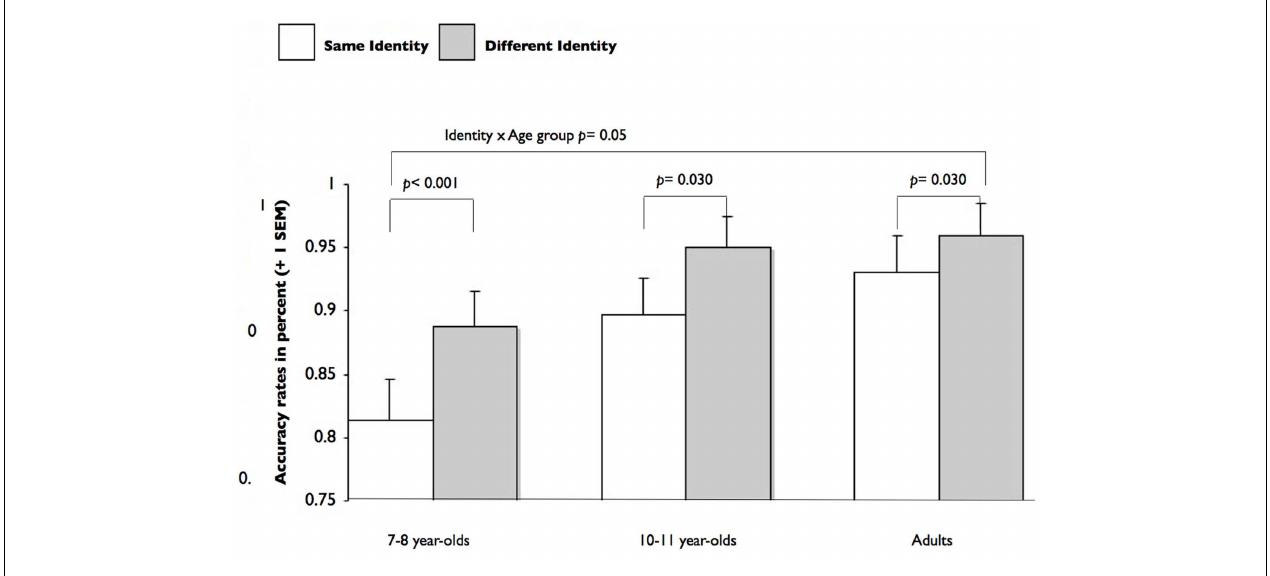
FIGURE 8 | Experiment 2: two-way interaction for identity × age group in the accuracy rates. The interaction between identity and age was due to significantly higher accuracy for detecting a change in identity in comparison